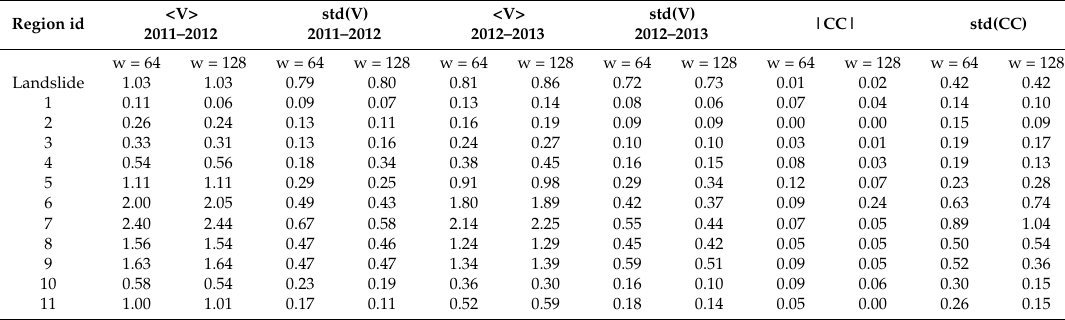
Figure 4. Ground Control Point (GCP) quality parameter maps for the satellite pair August 2011–August 2012. ( a ) Maximum of the cross-correlation matrix. ( b ) Ratio between the peak and the mean of the cross-correlation matrix. In both pictures, black contours indicate the kinematic regions as defined in [22]. Table 2. Summary of the obtained results. Data are reported in meters per year and have been averaged using the regions indicated in [22]. V–displacement velocity; CC–consistency check.